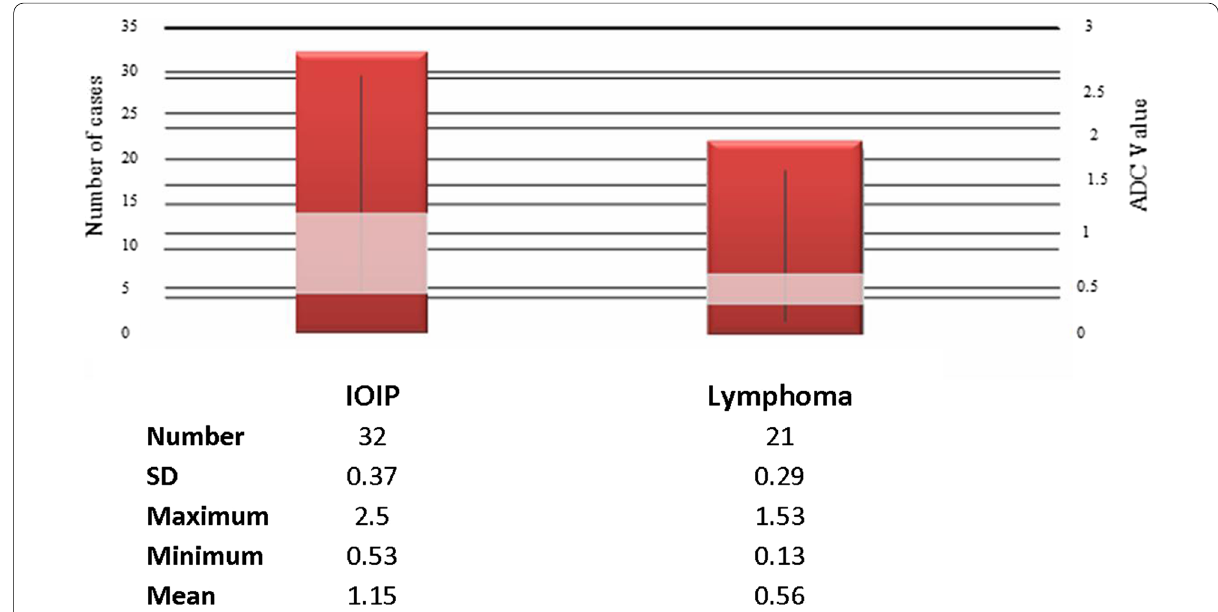
Fig. 1 Descriptive analysis of mean, SD and range of ADC values in both studied